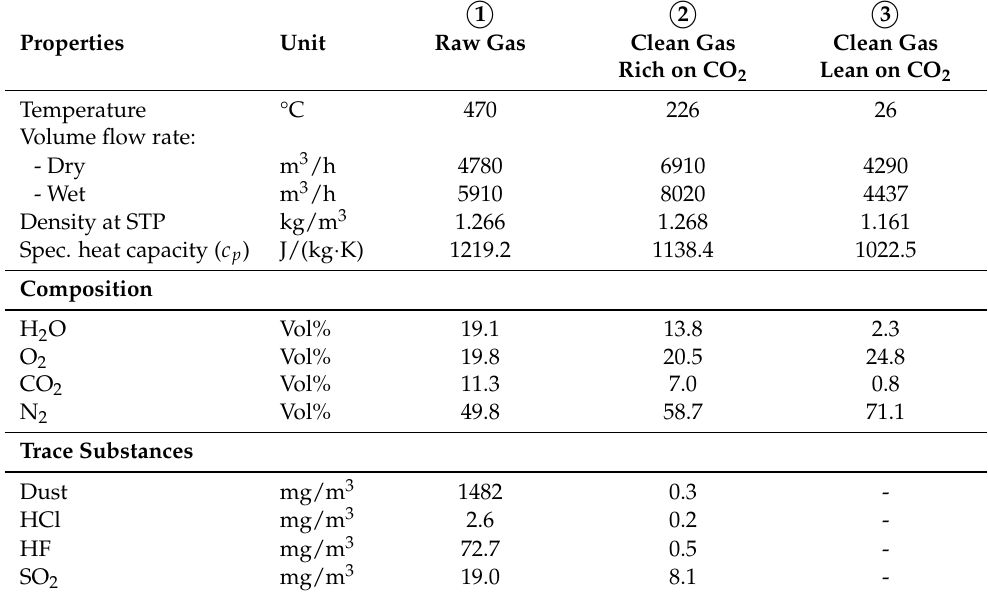
Table 2. Flue gas composition and properties for the examination of the CO 2 absorption plant. Based on the experimental results of [39], additional properties are calculated using [40,41]. STP = standard temperature and pressure conditions (0 °C; 1.0135 bar). Numbers of gas compositions refer to Figure